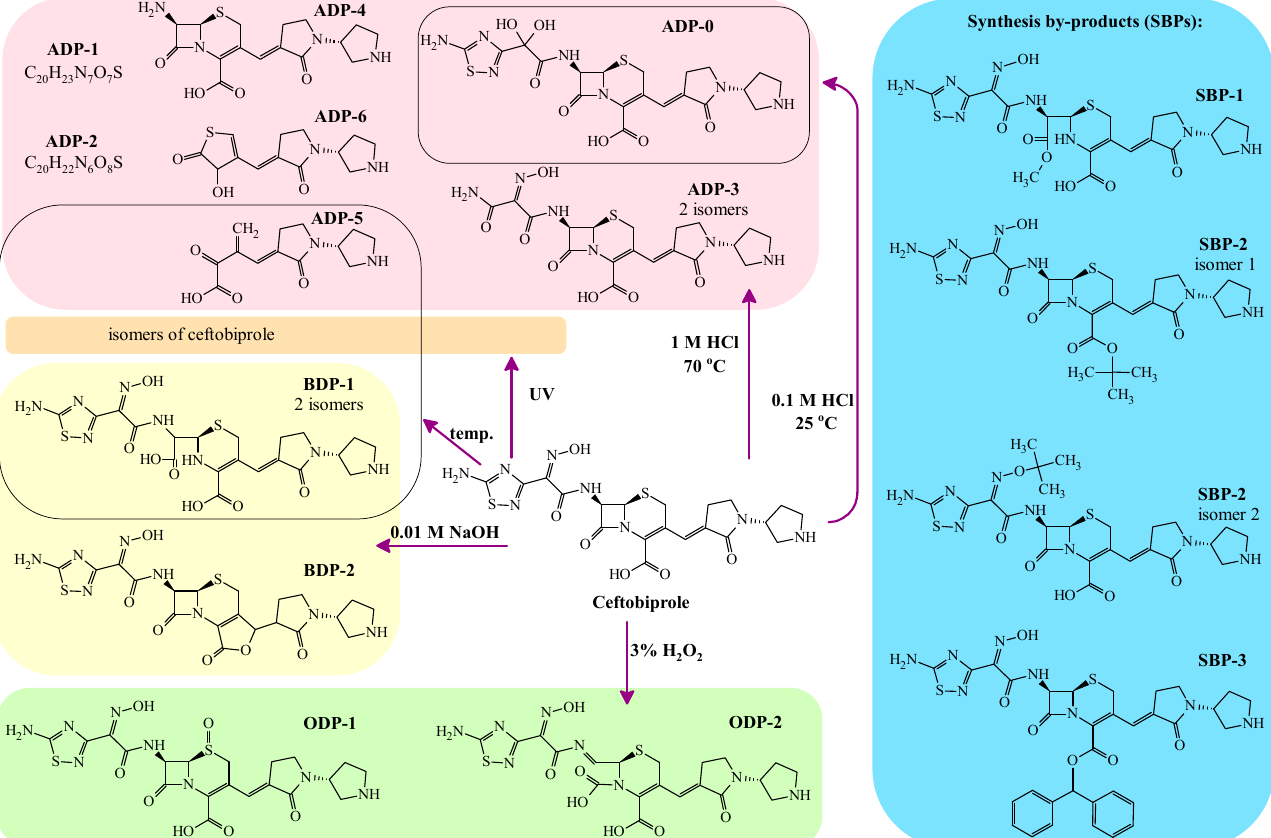
Scheme 1. Structure of DPs of ceftobiprole obtained under different degradation conditions together with the synthesis by-products (SBPs).